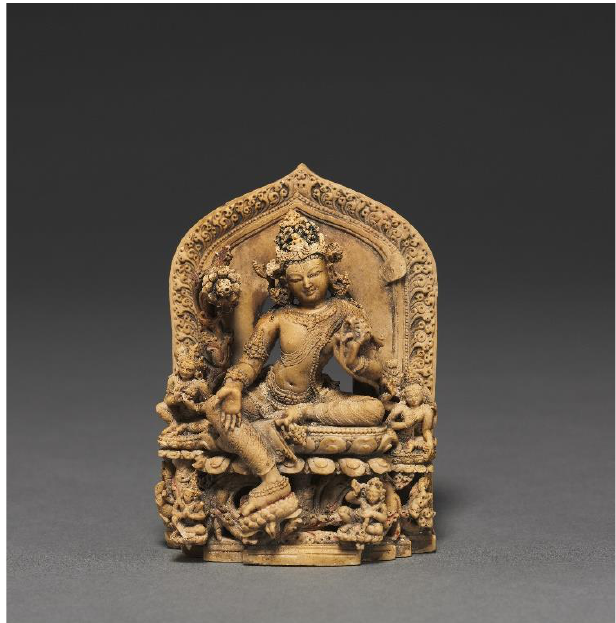
Figure 1. Lokesvara Khasarpana form of Avalokitesvara. Late 11th century. India, Nalanda, Pala Period(c.750 – c.1200). Steatite;Overall: 7.7 cm (3 1/16 in.). The Severance and Greta Millikin Purchase Fund 1991.155; Cleveland Museum of Art.